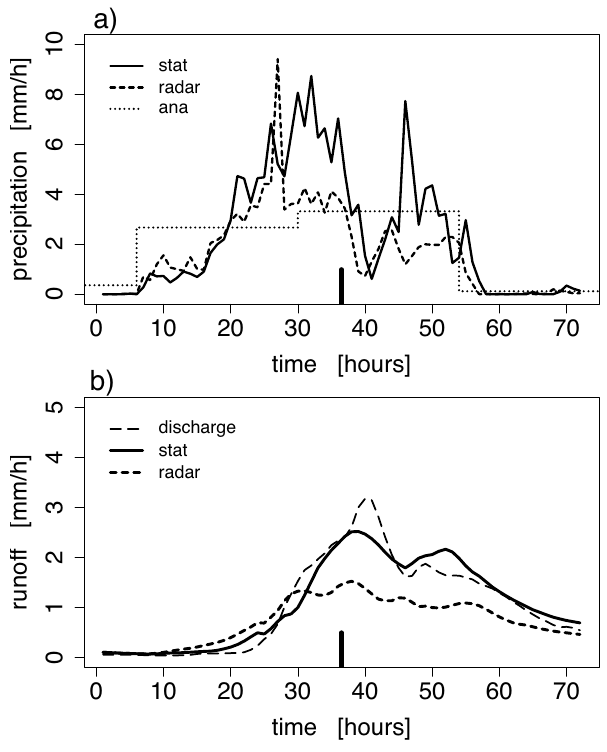
Fig. 5. TVM watershed-mean time series of (a) precipitation and (b) runoff rates during event IOP2b. Precipitation time series of corrected rain gauge (stat) and radar (radar) observations and as an- alyzed (ana) by Frei and H¨aller (2001) are shown. Hydrographs are simulated with rain gauge (stat) and radar data (radar) input. Additionally, observed runoff (discharge) is given. Hour 13 of 20 September 1999, is indicated by a bold tick